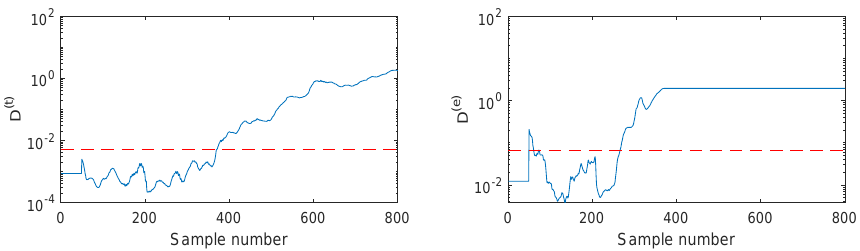
Figure 10. DPSVDD monitoring charts for fault